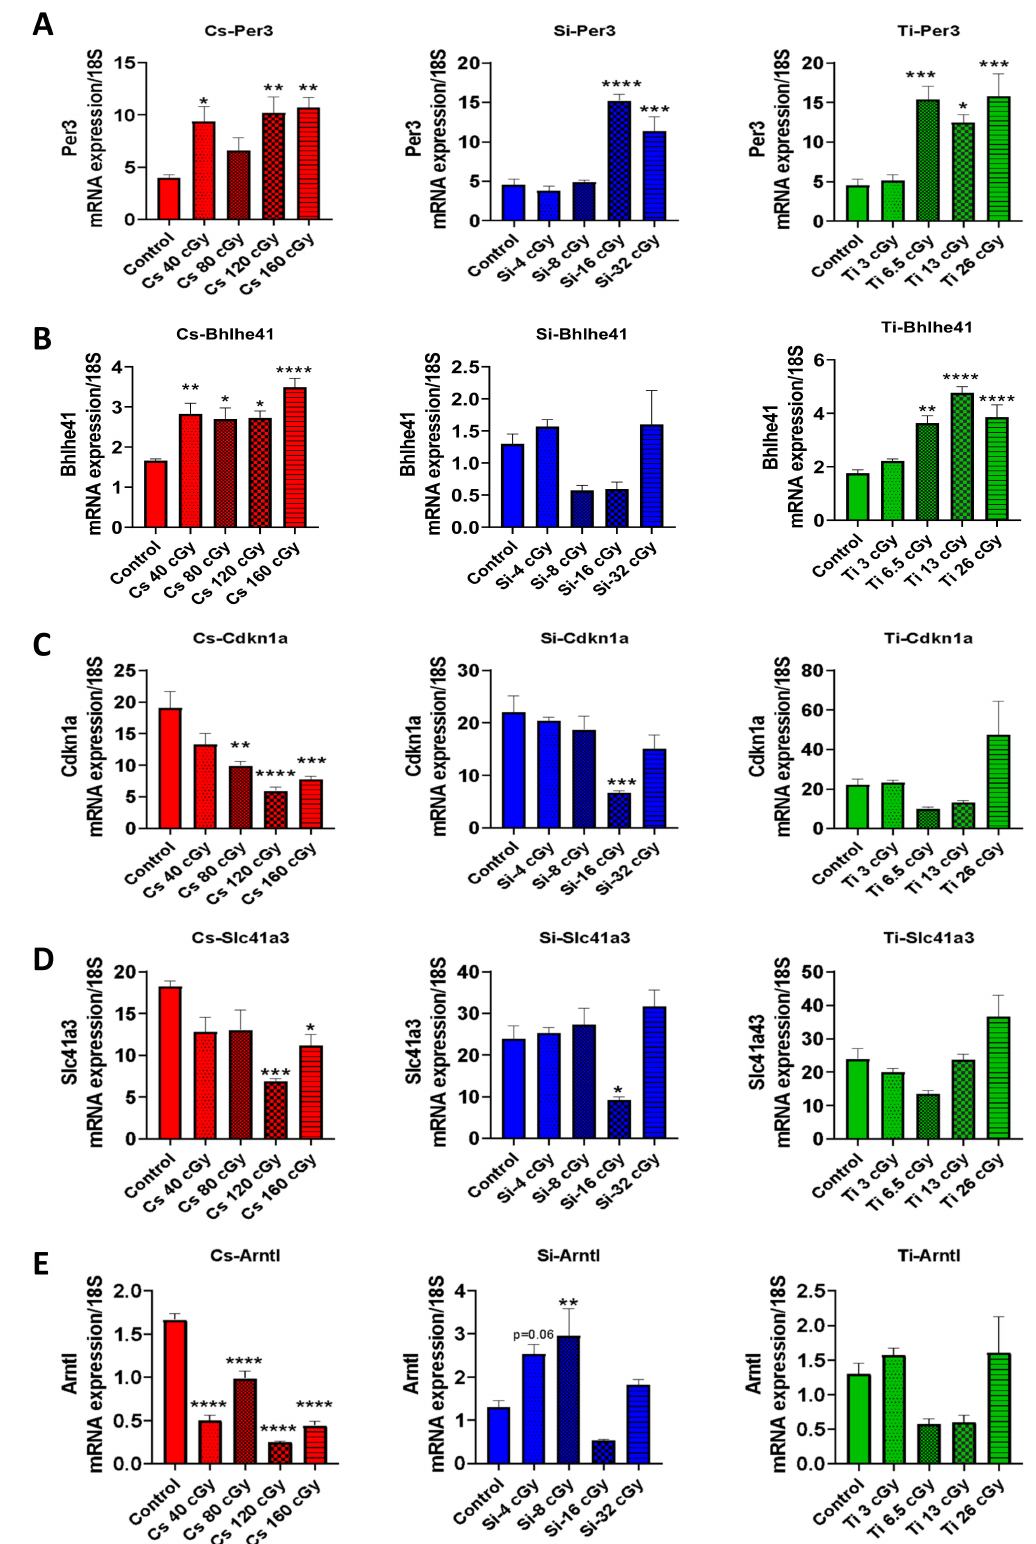
Figure 5. qRT-PCR validation of 5 of 12 common differentially expressed genes across all radiation types: mNA expression of ( A ) Per3, ( B ) Bhlhe41, ( C ) Cdkn1a, ( D ) Slc41a3, and ( E ) Arntl was measured by qRT-PCR in heart tissue ( n = 3 heart/group). Data were normalized using 18S rRNA. * p < 0.05, ** p < 0.01, *** p < 0.001, and **** p < 0.0001 compared to control groups. Per3, period circadian regulator 3; Bhlhe41, basic helix-loop-helix family member E41; Cdkn1a, cyclin-dependent kinase inhibitor 1A; Arntl, aryl hydrocarbon receptor nuclear translocator like; Slc41a3, solute carrier family 41 member